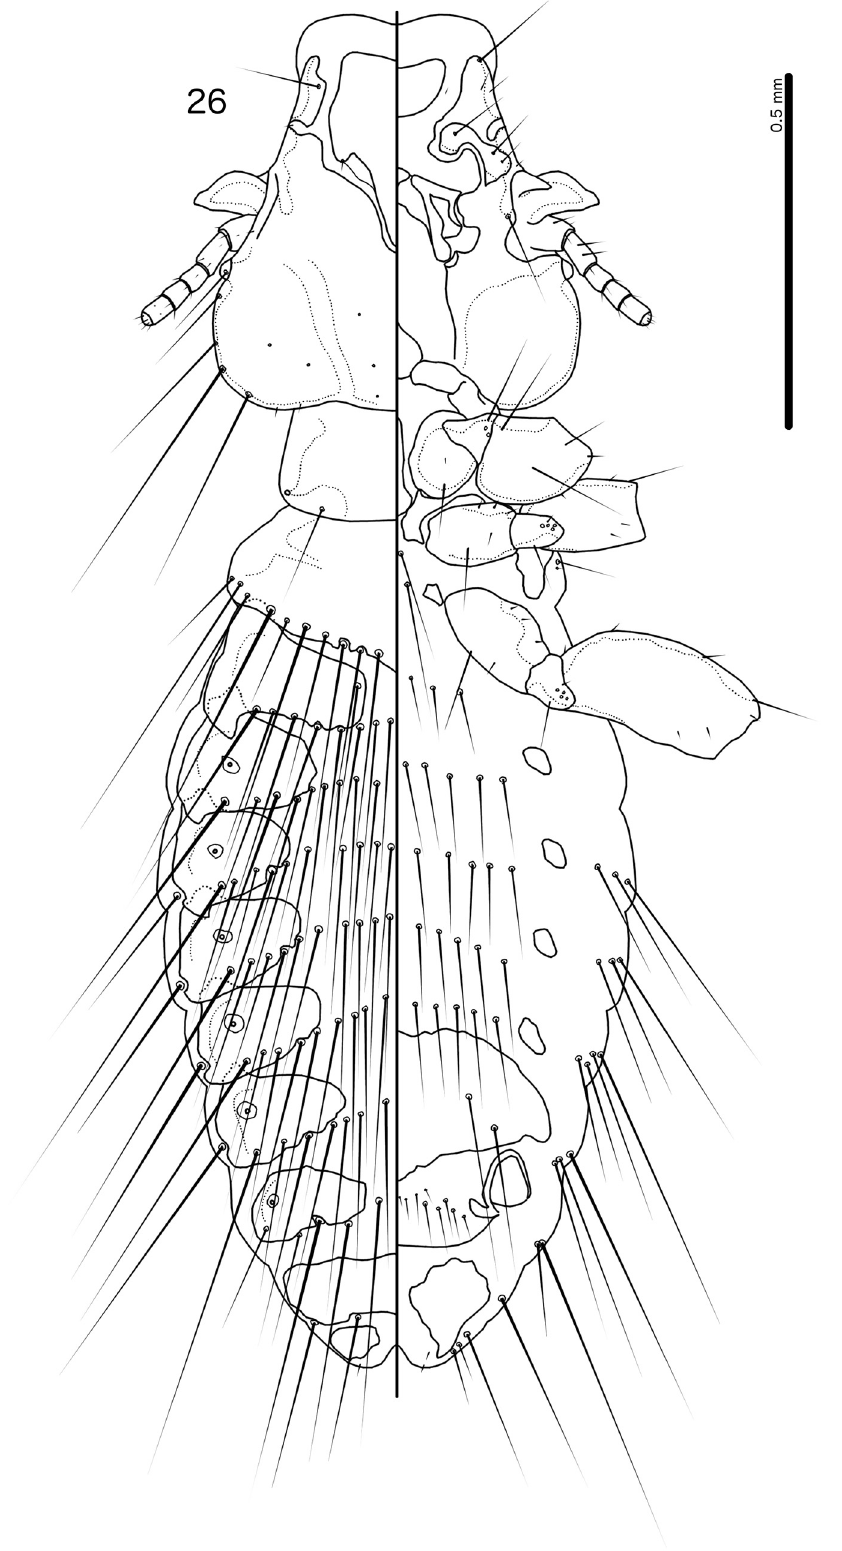
Fig. 26. Philopterus trepostephanus sp. nov. ex Tephrodornis virgatus fretensis Robinson & Kloss, 1920, female habitus, dorsal and ventral